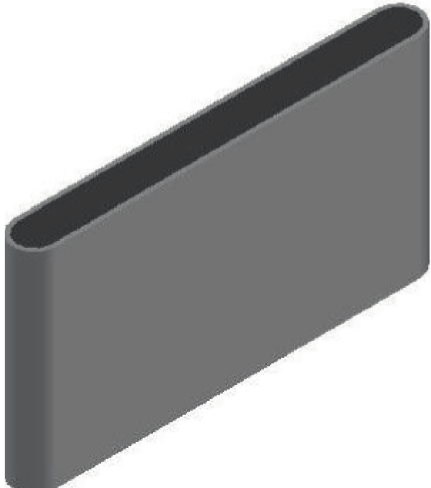
Figure 9: Concrete wall form constructed using CC procedure and filled with